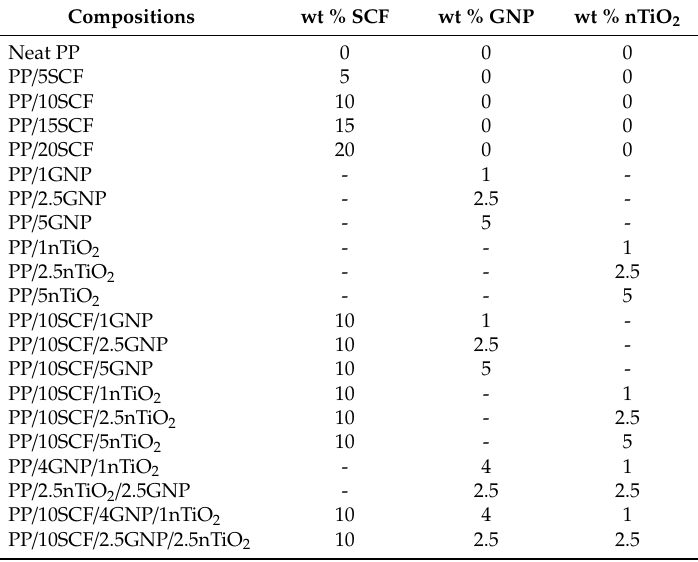
Table 2. Composition of the polypropylene